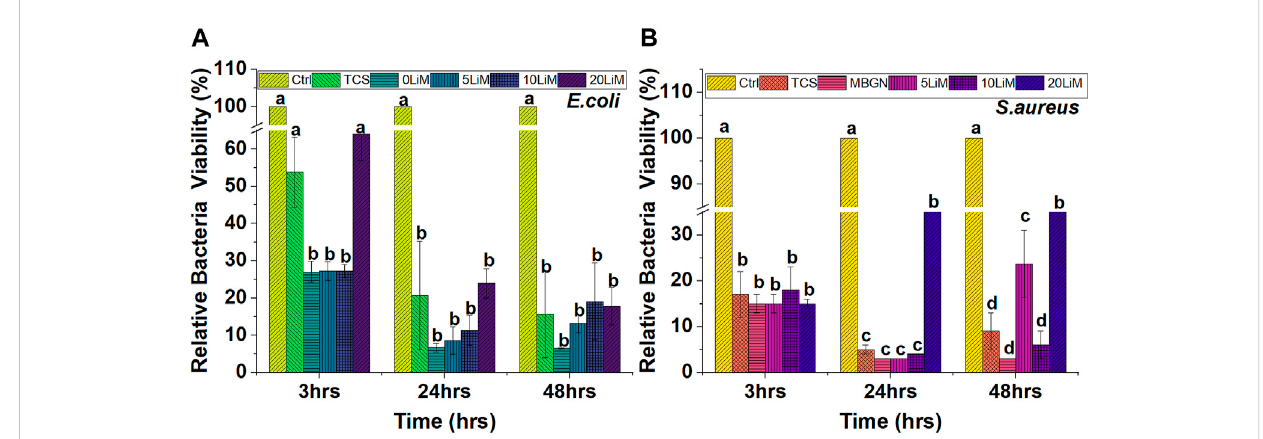
FIGURE 11 The effect of the particles on Gram negative — (E) coli (A) and Gram positive bacteria — S. aureus (B) after 3, 24 and 48 h. Dissimilar letters indicate means that are statistically different from each other. ( n = 3; * = p > 0.05).